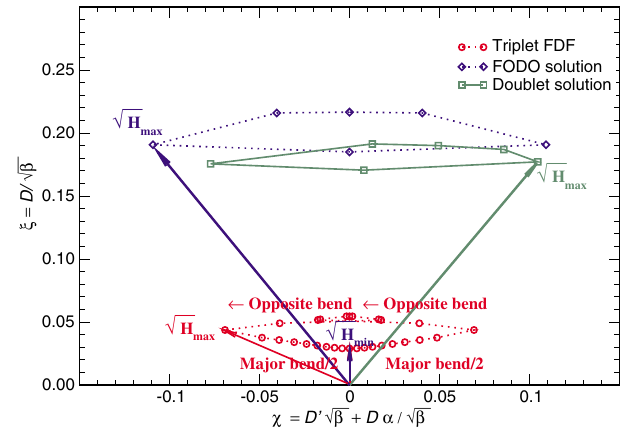
FIG. 5. (Color) Comparison of the path length calculations by the three codes SYNCH , PTC , and COSY INFINITY over the muon acceleration range from 10 and 20 GeV. Results obtained by the PTC and COSY INFINITY codes are almost